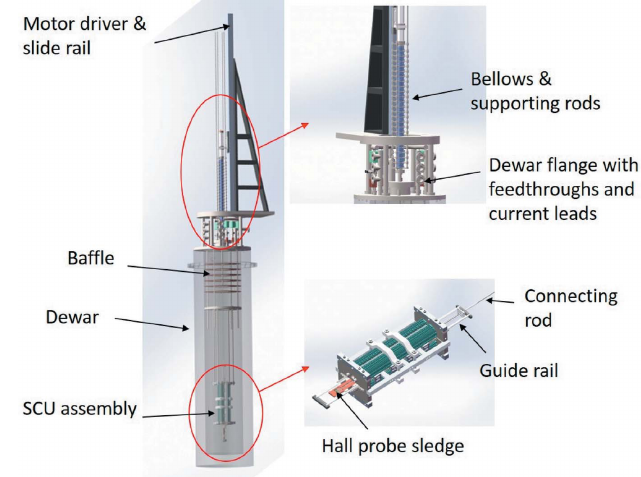
Figure 8 Schematic drawing of the vertical test system. Figure 6